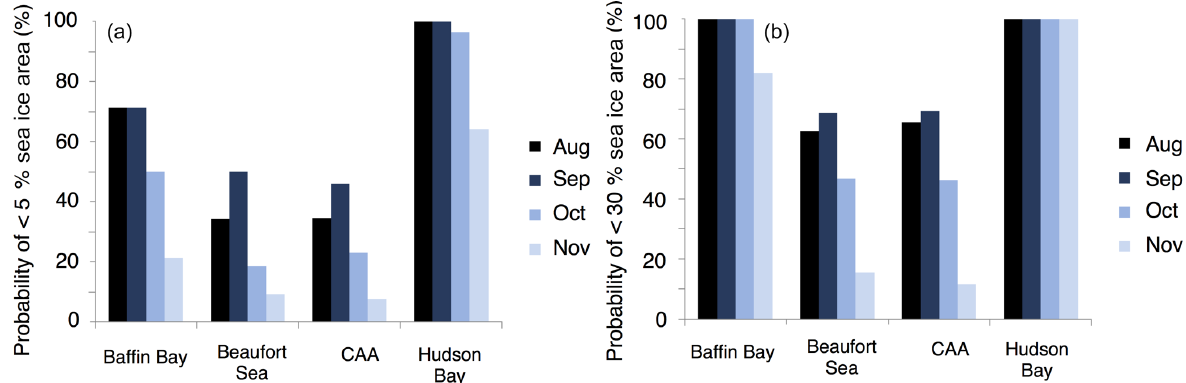
Figure 14. Probability of sea-ice-free conditions by 2050 from the CMIP5 multi-model mean using a 5% (a) and 30% (b) sea ice area